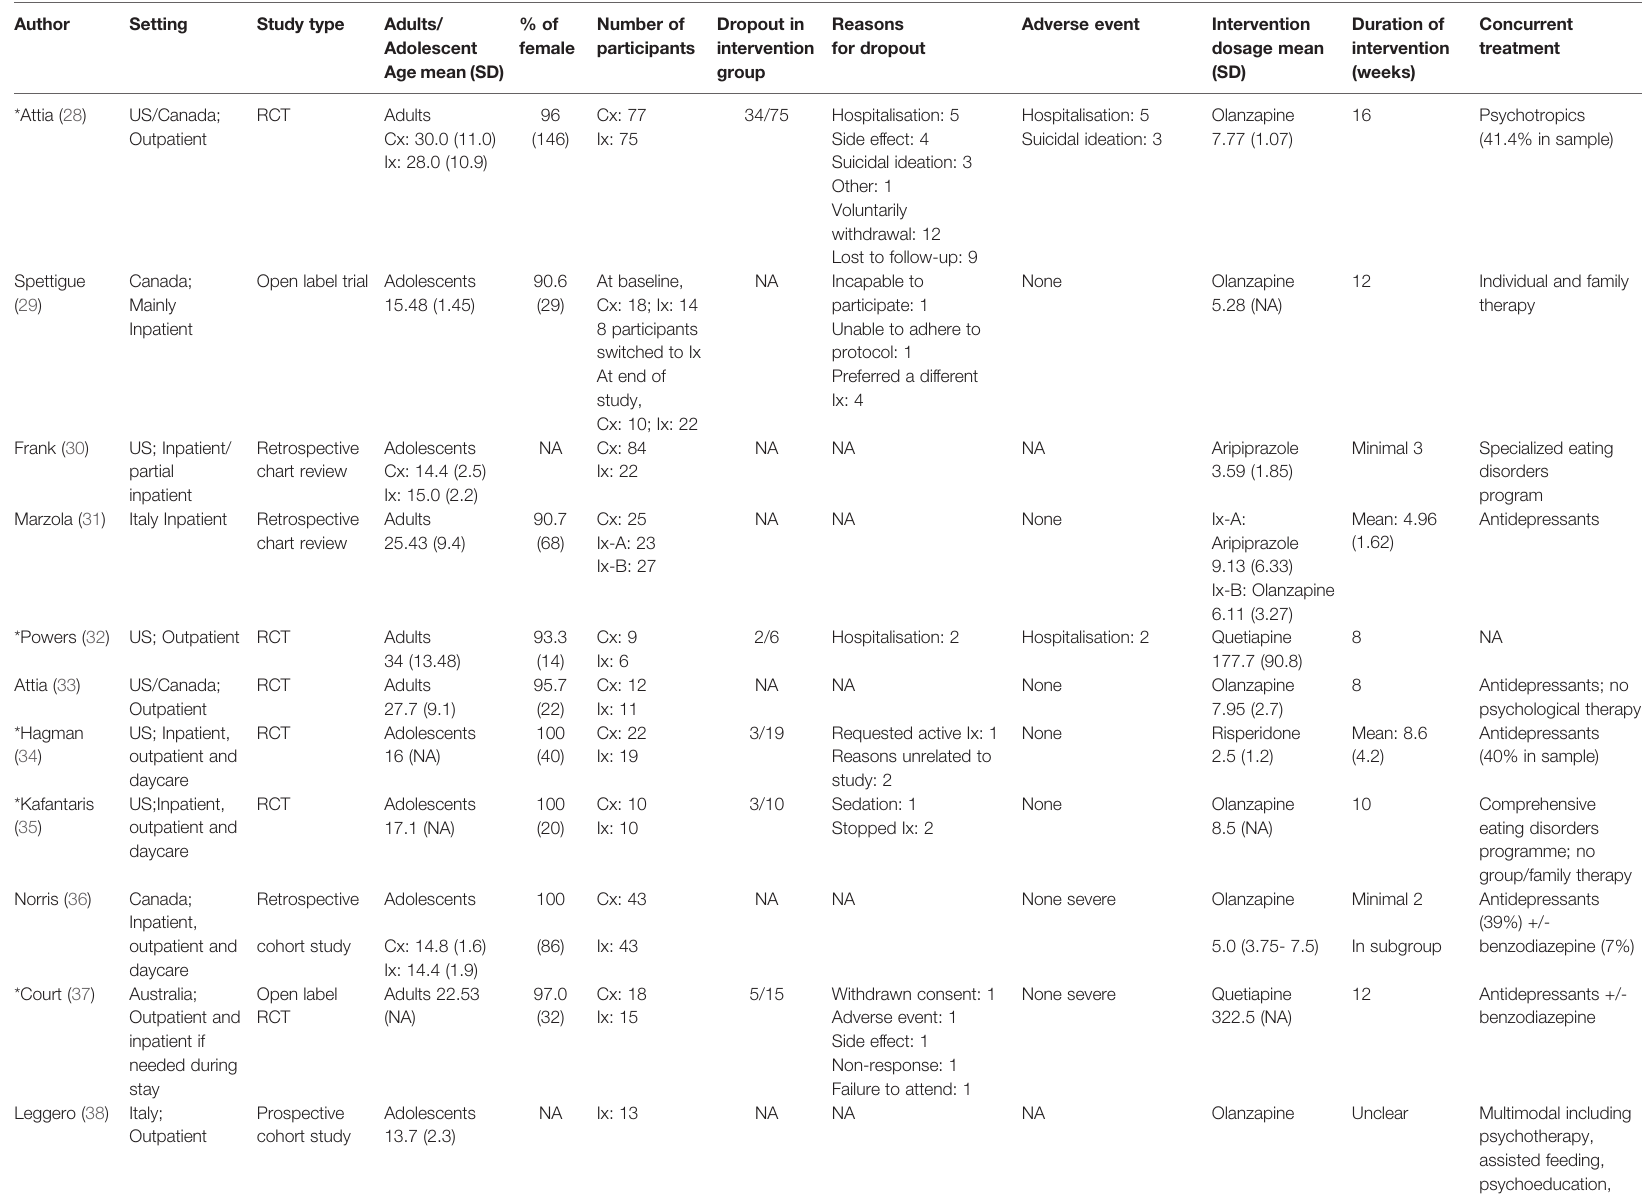
TABLE 1 | Summary table of primary studies included in the systemic